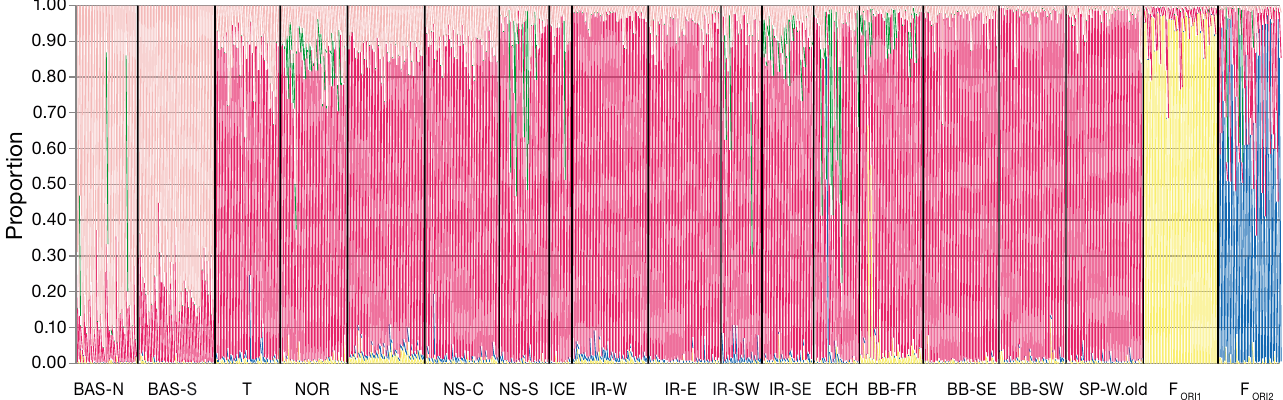
Fig. 2. STRUCTURE results for all wild and farmed samples of turbot genotyped for 755 SNPs, showing K = 5 different ge- netic clusters, each represented with a different colour. Population codes in the x -axis, where each vertical bar corresponds to a single individual: BAS (Baltic Sea)-N (North), -S (South); T (transition area between the Atlantic and the Baltic Sea; Sk- agerrak location); NOR (Norway Sea); NS (North Sea)-E (East), -C (Central), -S (South); ICE (Iceland); IR (Ireland)-W (West), -E (East), -SW (South West), -SE (South East); ECH (English Channel); BB (Biscay Bay)-FR (France), -SE (South East), -SW (South West); SP-W.old (Spain West old sample); F _ORI1 , F _ORI2 : farmed turbot from 2 distinct origions